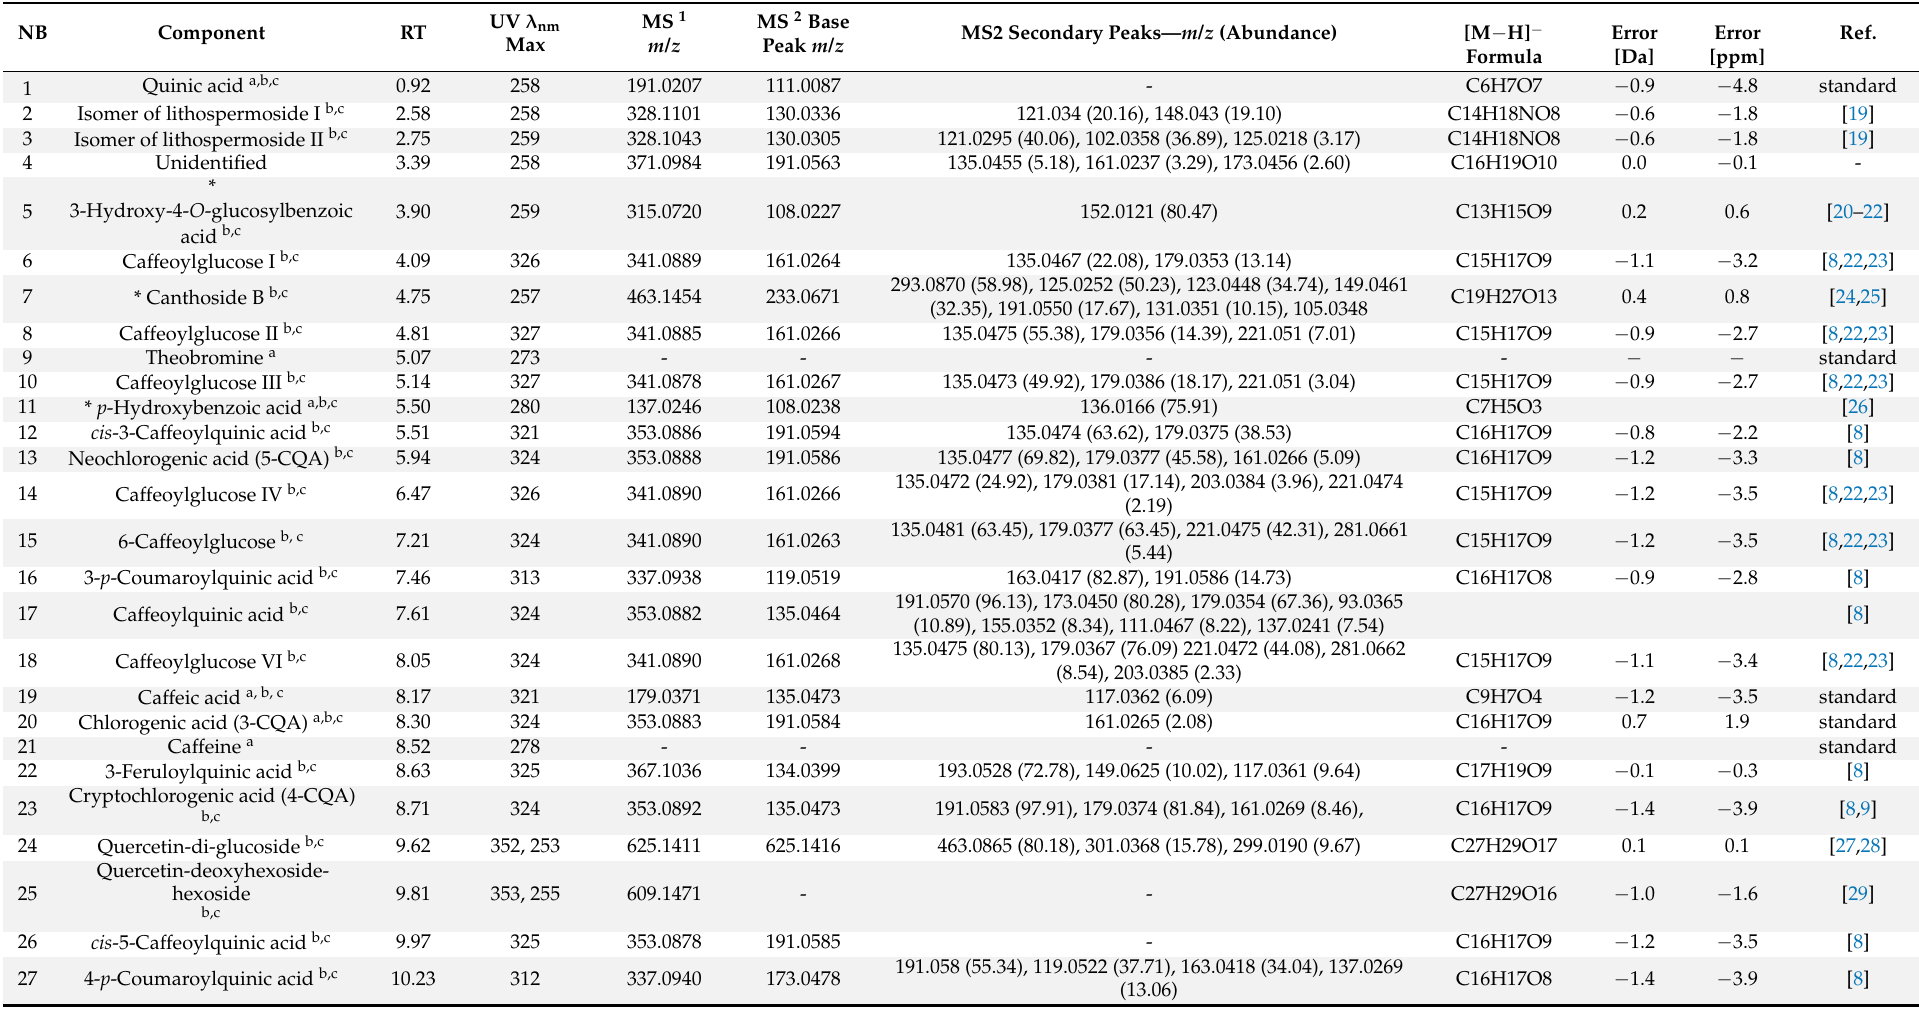
Table A1. Expanded results of UHPLC-DAD-MS/MS analysis of analysed Ilex leaves